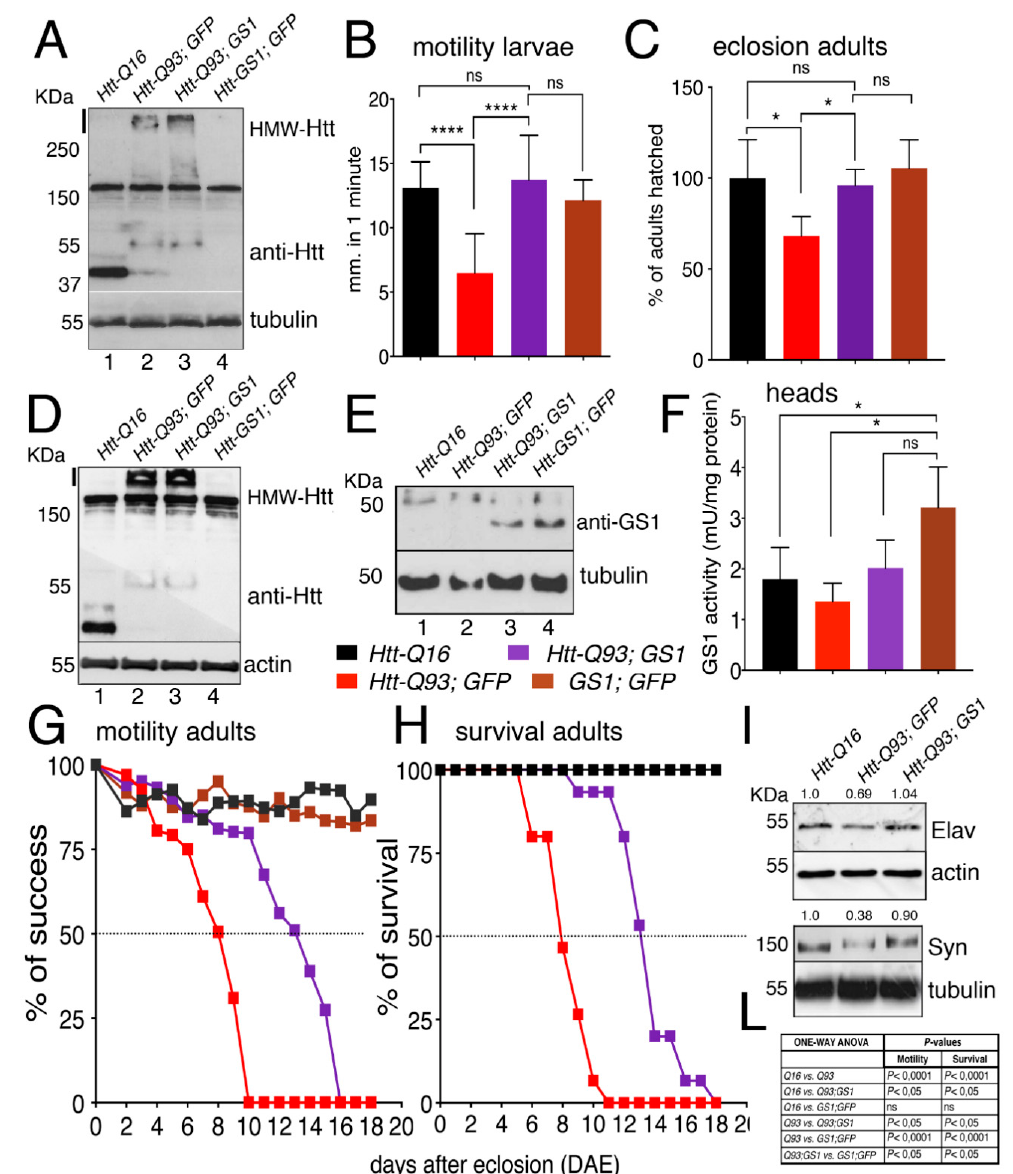
Figure 2. Expression of GS1 in neurons rescues motility defects and neuronal death induced by Htt-Q93. ( A ) Western blot showing the relative amounts of the protein huntingtin in lysates from 20 third instar larval brains expressing the indicated transgenes using the pan-neuronal driver elav-Gal4. Tubulin was used as the loading control. The band of about 30 KDa in lane 1 represents the Htt-Q16 protein, while the band at 55 KDa, in lanes 2 and 3, represents the Htt-Q93 protein. The high molecular weight proteins recognized by the anti-hHTT antibody also present in lanes 2 and 3 represent the mutant Htt high form that jammed in the stacking gel (indicated by a black line on the side). The 150 KDa band present in all the lanes is aspecific, since it is recognize by the mHtt antibody also in lane 4 where Htt is not expressed. A similar description is applied to the Western in Figure 2D. ( B ) Quantification of the motility in third instar larvae of the indicated genotype, where the data are expressed as the distance traveled in one minute measured in mm, and 10 larvae from each genotype were used the experiment was repeated three times (see Supplementary Figure S4C–E, movies S1 and S2). ( C ) Eclosion timing of adult females of the relative genotypes. ( D , E ) Western blots showing the respective amounts of huntingtin and GS1 proteins in lysates from 15 heads for each genotype, of females at 8 days after eclosion (DAE), wherein actin and tubulin were used as a loading control, respectively. In 2E is visible a band of about 30–40 KDa only when the UAS-GS1 transgene is expressed (lane 3 and 4). The band